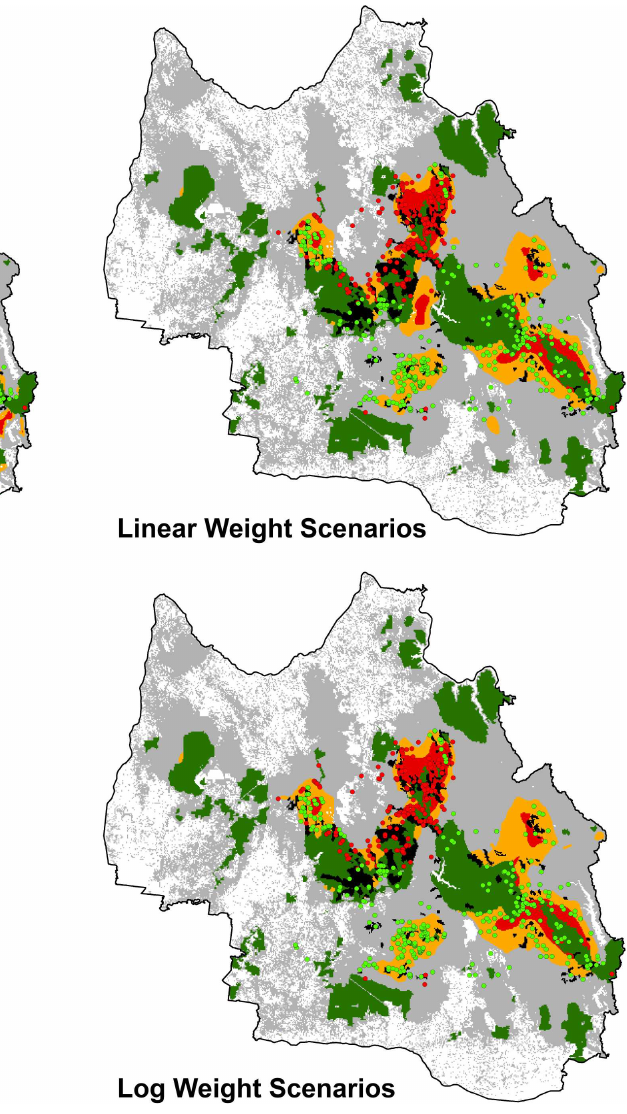
Fig 3. Three Zonation solutionsmodellingthe expansionof the reserve system for Leadbeater’s Possum generatedusing: (a) equal,(b) linear and (c) log species weightingschemes based on threat status and the Maxent SDMs for each species. The equal weightedscenarioresulted in the largest reserve expansionin area under scenario1 and the linear scenario resultedin the largest area for reserve expansionin area under Scenario2 (see text).